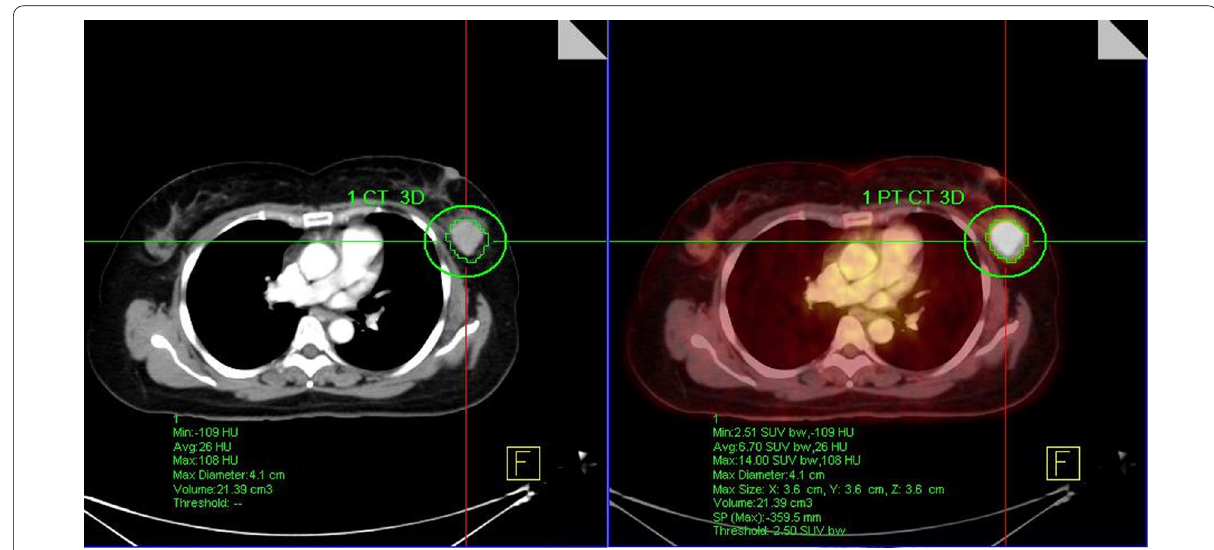
Fig. 2 Fifty-six-year-old female, post-menopausal with recurrent primary left breast carcinoma. Axial CT (left) shows an enhanced left breast mass with the correlated FDG-avid mass on the fused PET-CT image (right), SUVmax 14.00 g/dl. The FDG avidity of the lesion is more than that of the mediastinal blood pool